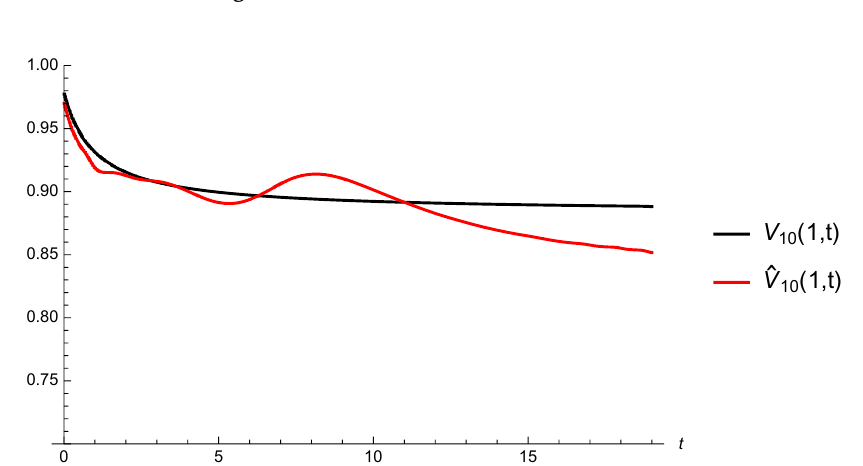
Figure 2. Difference of 9th and 10th iterations.